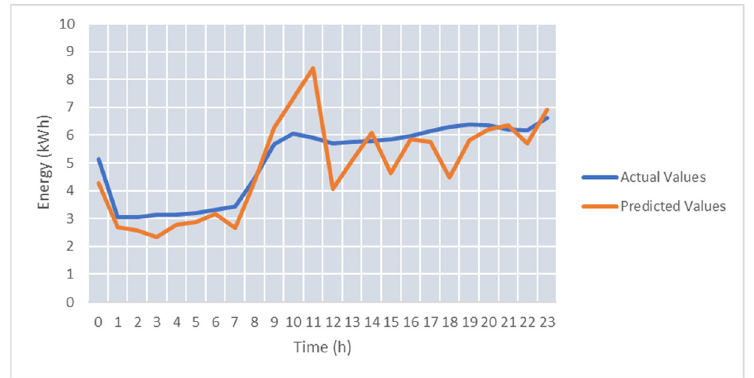
Figure 12. TC-S3: best day (SMAPE = 11.2%), with energy and temperature as features.